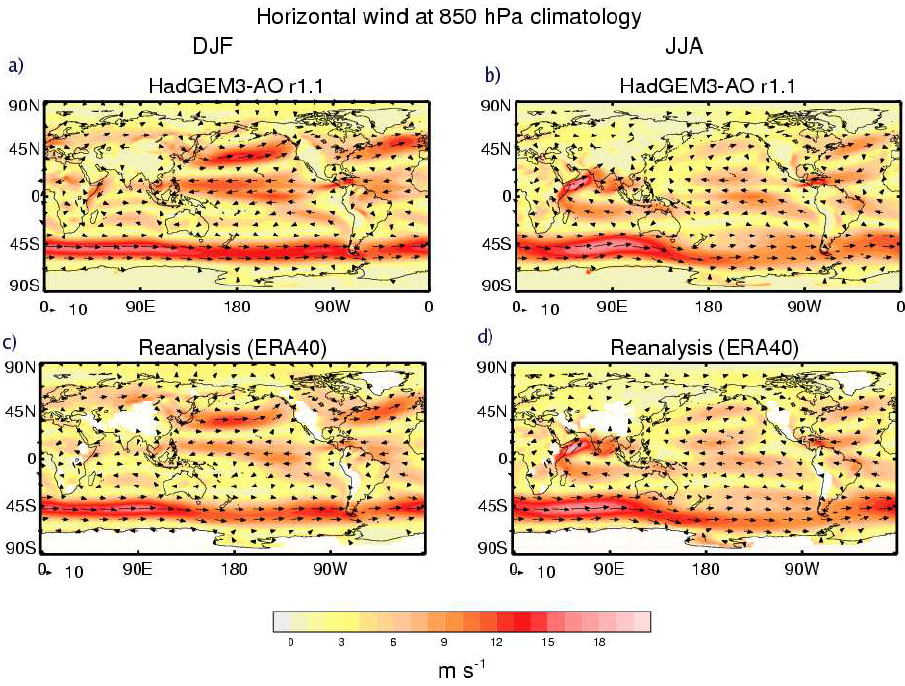
Figure 9: Horizontal wind climatology (in m s -1 ) of HadGEM3 r1.1 (plots a-b), reanalysis from (cid:4)(cid:2) Fig. 9. Horizontal wind climatology (in m s − 1 ) of HadGEM3 r1.1 (plots a–b ), reanalysis from the ECMWF 40 year reanalysis (ERA40, the ECMWF 40 year reanalysis (ERA40, Uppala et al., 2005) covering the period 1979 to 1998 (cid:5)(cid:2) Uppala et al., 2005) covering the period 1979 to 1998 (plots c–d) for the seasons December to February (plots a and c ) and June to August (plots c-d) for the seasons December to February (plots a & c) and June to August (plots b & d). (cid:6)(cid:2) (plots b and d ). The colours show windspeed and arrows show wind direction. The colours show windspeed and arrows show wind direction. (cid:7)(cid:2) (cid:8)(cid:2)